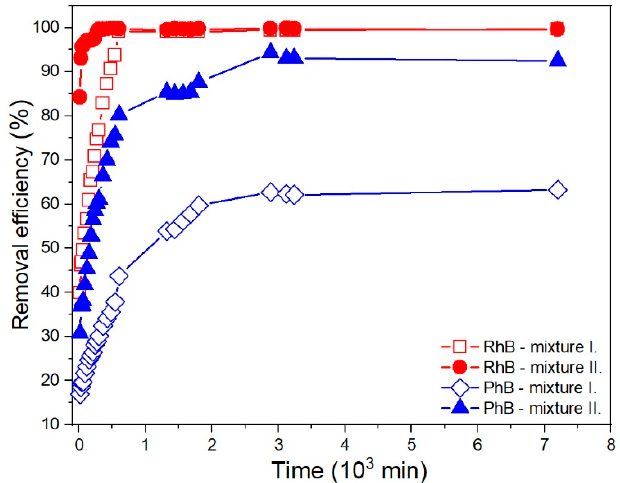
Figure 9. Evolution of RhB and PhB removal efficiency with time for the mixtures with the ratio of the amount of dye to the mass of CCP sample of 1.60 μ mol·g − 1 (mixture I.) and 0.40 μ mol·g − 1 (mixture II.).